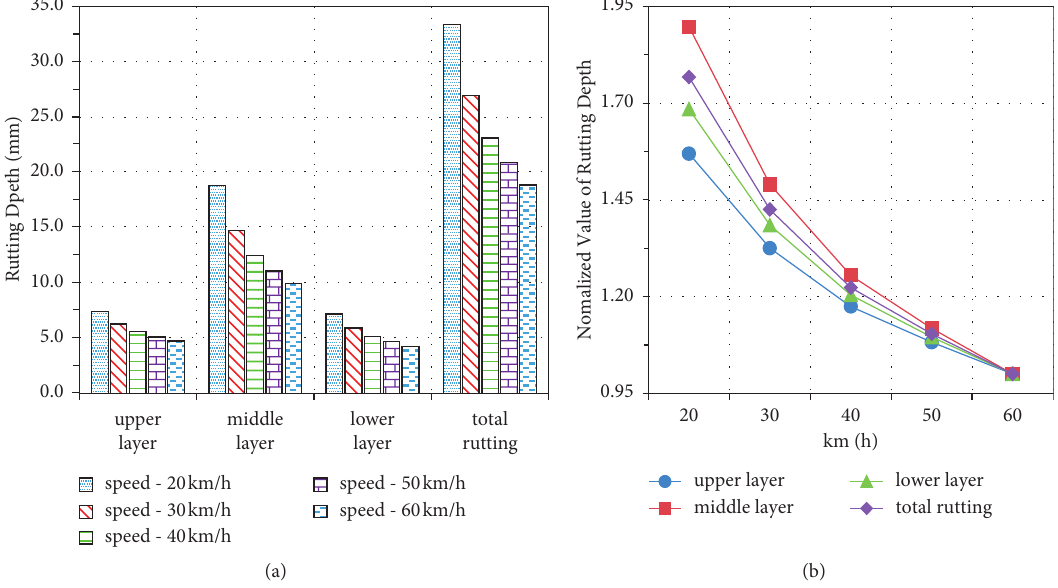
Figure 17: Rutting depth under different SS: (a) normal value and (b) standardized